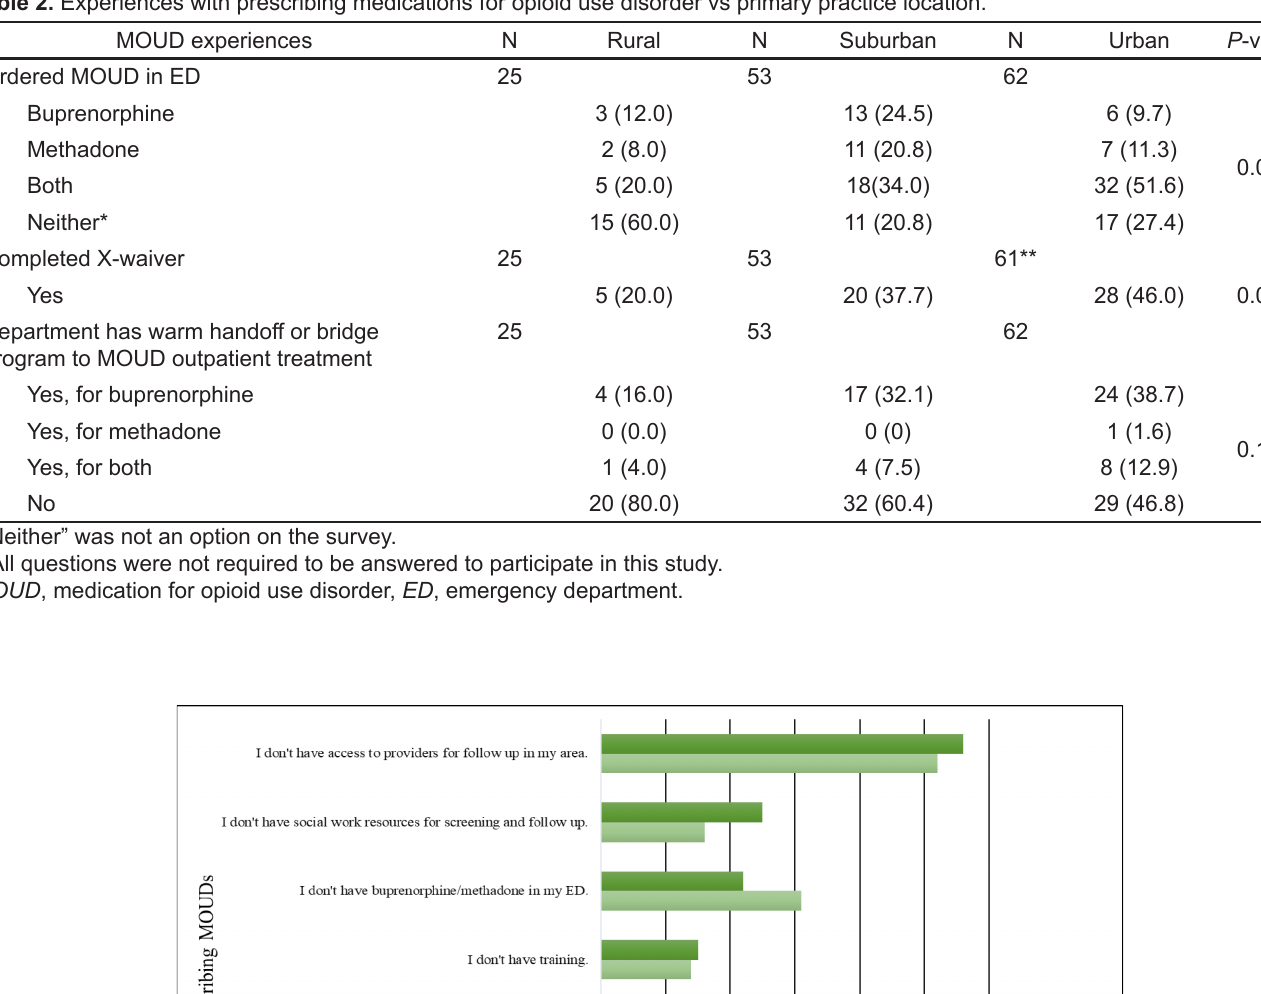
Table 2. Experiences with prescribing medications for opioid use disorder vs primary practice location.